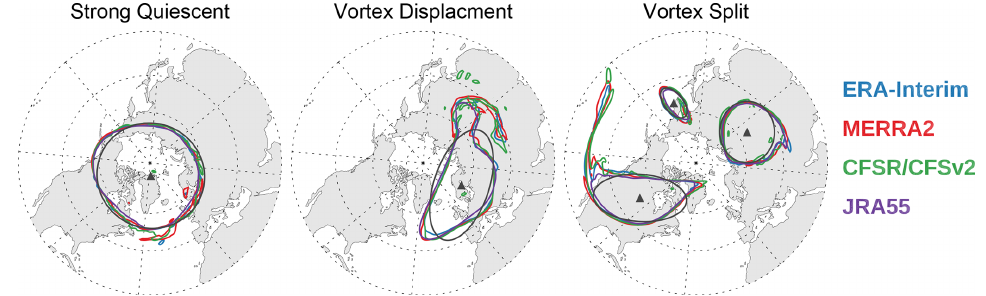
Figure 11. sPV maps at 850K during a strong quiescent period of the polar vortex, during a vortex displacement, and during a vortex split. These maps are for 8 January 2009, 23 January 1987, and 25 January 2009, respectively. These maps show the raw sPV fields; i.e., vortices were not excluded by the minimum area threshold. Dark gray lines show equivalent ellipses computed for the REM sPV for these days, triangles represent the center of those equivalent